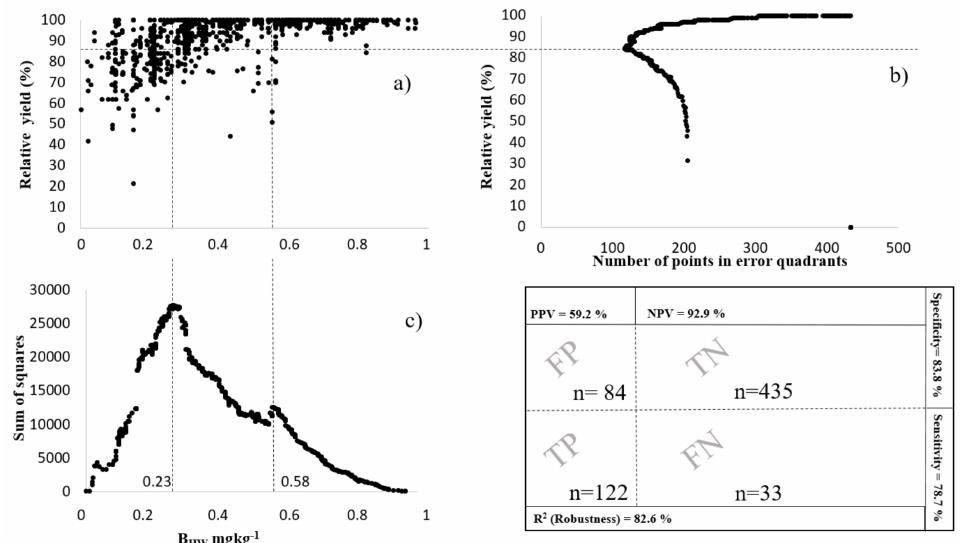
Figure 4. Construction of the diagnostic and statistical model of the Cate–Nelson classification for hot water boron showing the ( a ) Cate–Nelson graph for the critical thresholds identified; ( b ) number of points outside the model for determination of the critical relative yield ( RY ); ( c ) sum of squares for determination al of the critical B HW; and summary table (lower right)n: Number of points in the di ff erent quadrants; Performance indicators of the partition model. R 2 , accuracy; NPV, negative predictive value; PPV, positive predictive